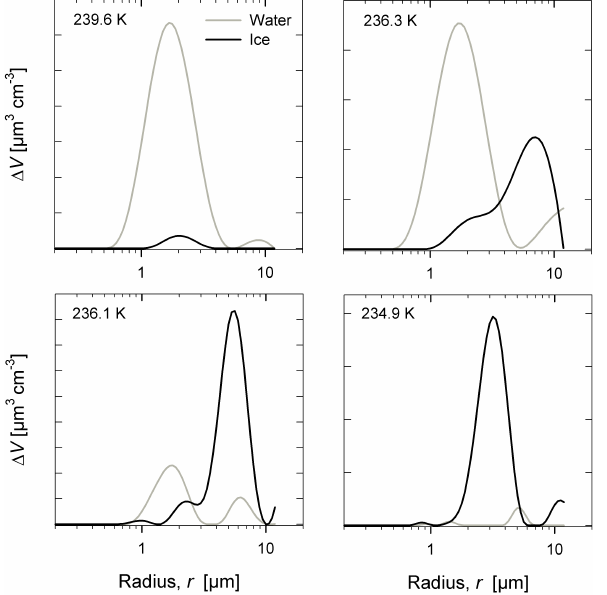
Fig. 4. Volume size distributions obtained using the aerosol re- trieval procedure with the experimental spectra from freezing ex- periments using medium droplets in Fig. 3. The corresponding can- didate freezing temperatures are indicated for the individual exper- iments.